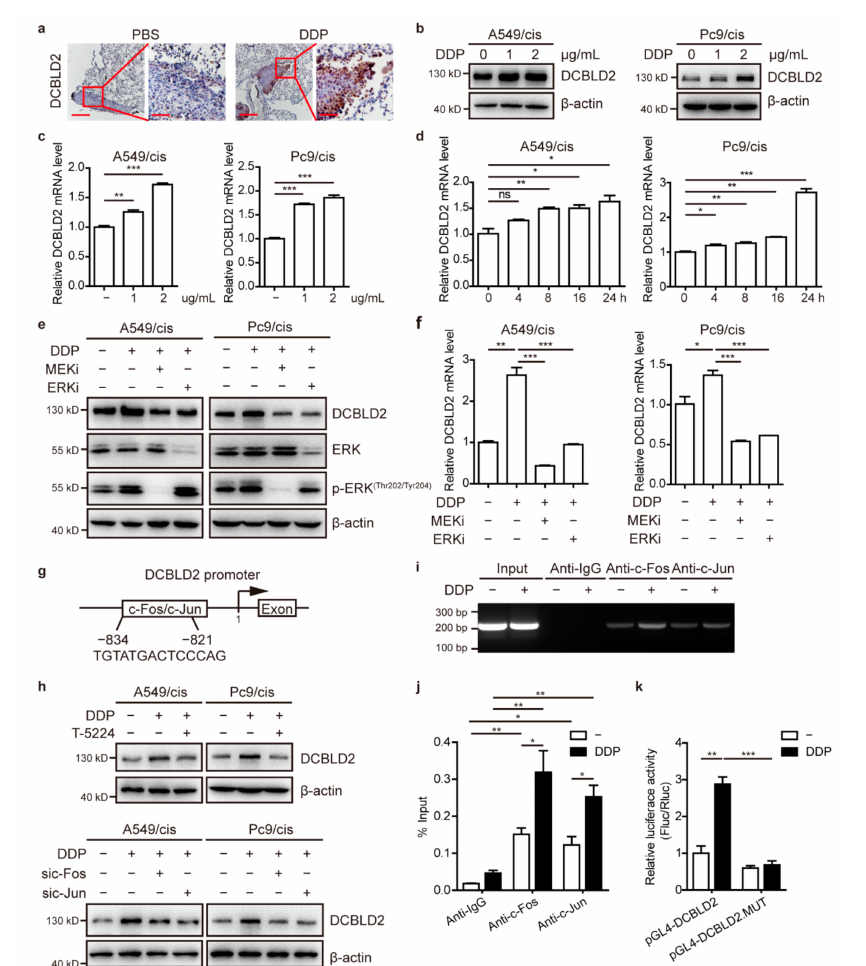
Figure 6. Cisplatin upregulates DCBLD2 expression by the ERK/AP-1 signaling pathway. ( a ) Representative IHC images of DCBLD2 expression in primary tumor tissues from Figure 1a. Scale bar: 200 µ m (left), 50 µ m (right). ( b , c ) Western blot assays ( b ) and RT-PCR assays ( c ) of